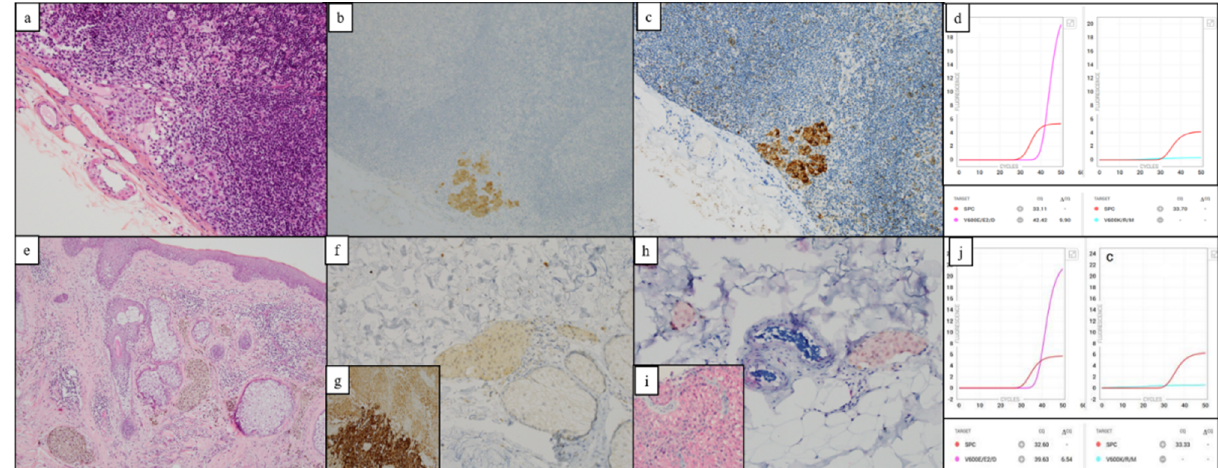
Figure 2. Example of discordant results. ( a – d ), a micro-metastatic sentinel lymph node that expressed BRAF V600E when analyzed by IHC and was negative with the BRAF Idylla test despite delayed amplification. ( e – g ), a subcutaneous melanoma metastasis considered negative for IHC BRAF V600E when compared to the control. ( g ) (some background noise due to intracytoplasmic pigment), when stained with a red chromogen the interpretation remains equivocal ( h , i ) and positive with the Idylla method. ( a , e ) HES stain ×20; ( b ) Melan A IHC ×20 (Clone A103, Roche Ventana); ( c , f ) BRAF V600E IHC ×20 (Clone VE1, Roche Ventana); ( g ) BRAF V600E IHC ×40 external control showing viable tumor cells and melanophages; ( h ) BRAF V600E IHC ×20 (Clone VE1, Roche Ventana—Red detection kit); ( i ) BRAF V600E IHC ×40 external control viable tumor cells with red chromogen; ( d , j ) Amplification curves with the Idylla Explore tool.